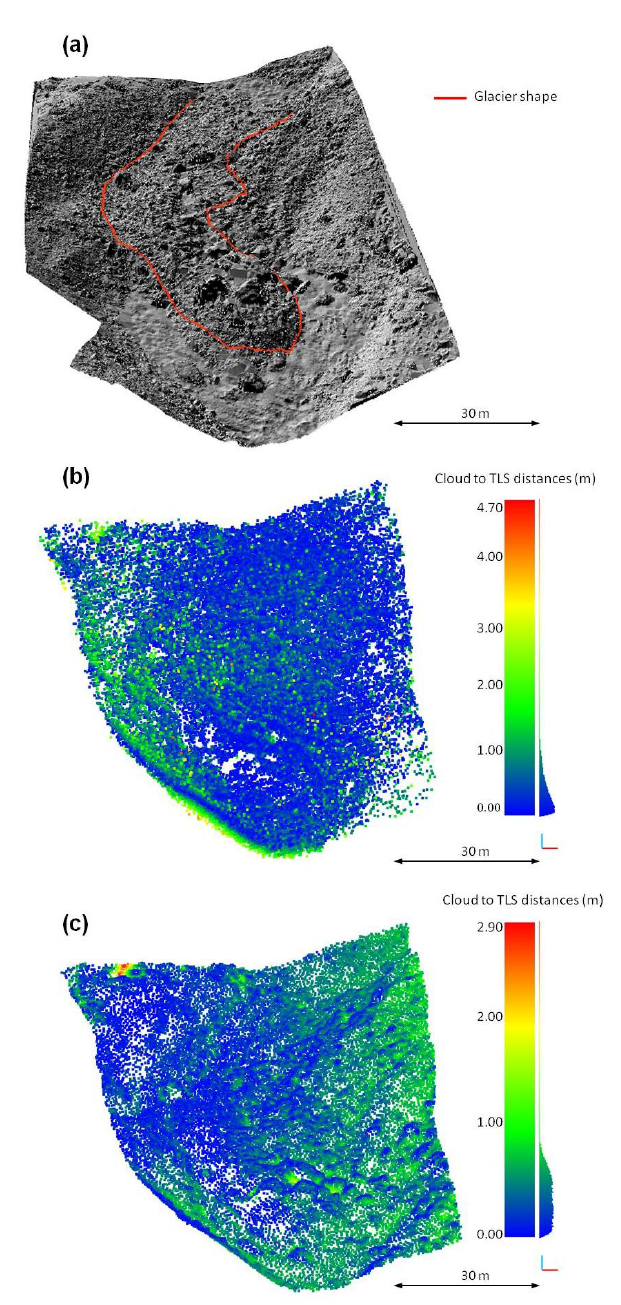
Figure 4. ( a ) 3D view of the Corral del Veleta rock glacier hillshade elaborated with the Terrestrial Laser Scanner (TLS) point cloud; below, point clouds obtained by ( b ) the semi-automatic 3D photo-reconstruction and ( c ) the fully automatic 3D photo-reconstruction methods and their distances to the TLS point cloud calculated using the cloud-to-cloud distances method proposed by Girardeau-Montaut et al.